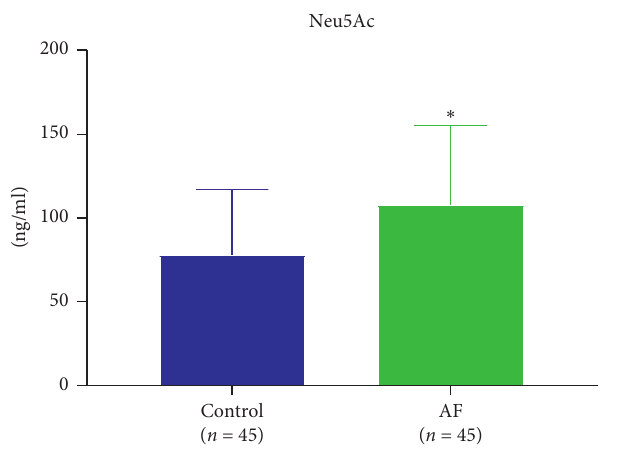
Figure 1: The plasma level of Neu5Ac was significantly increased in the AF group compared with the level in the control group. ∗ p < 0 . 05 for significant differences.